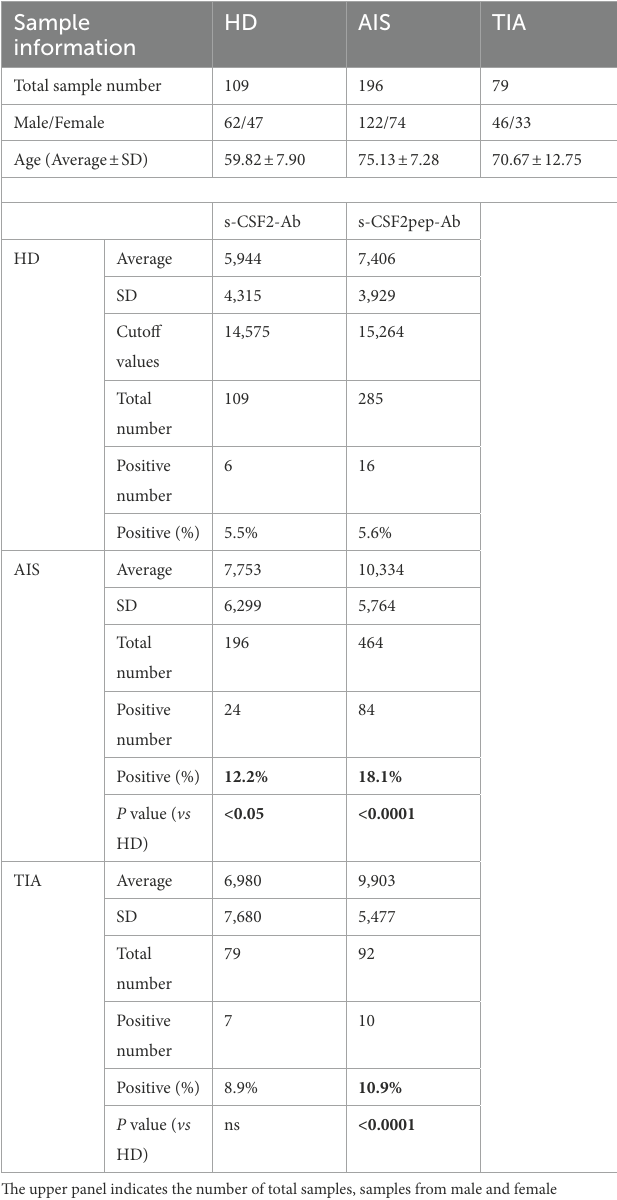
TABLE 1 Comparison of the s-CSF2-Ab and s-CSF2pep-Ab levels in HDs versus those in patients with AIS and TIA. Sample